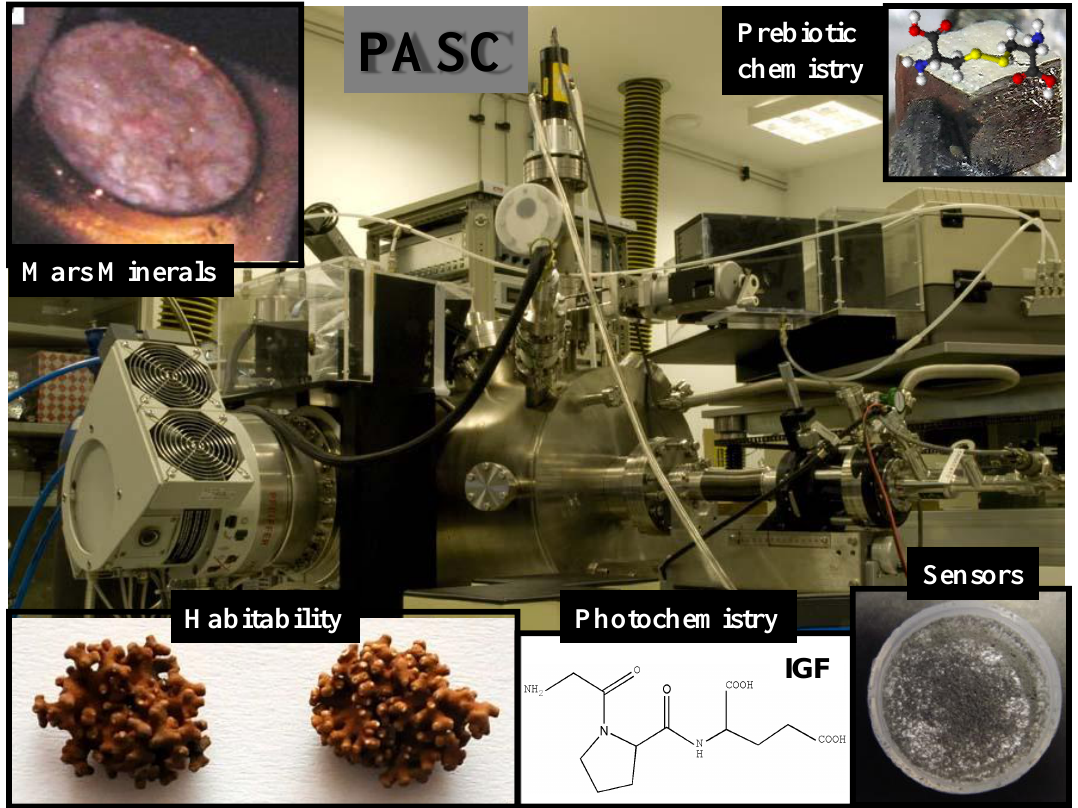
Habitability Photochemistry